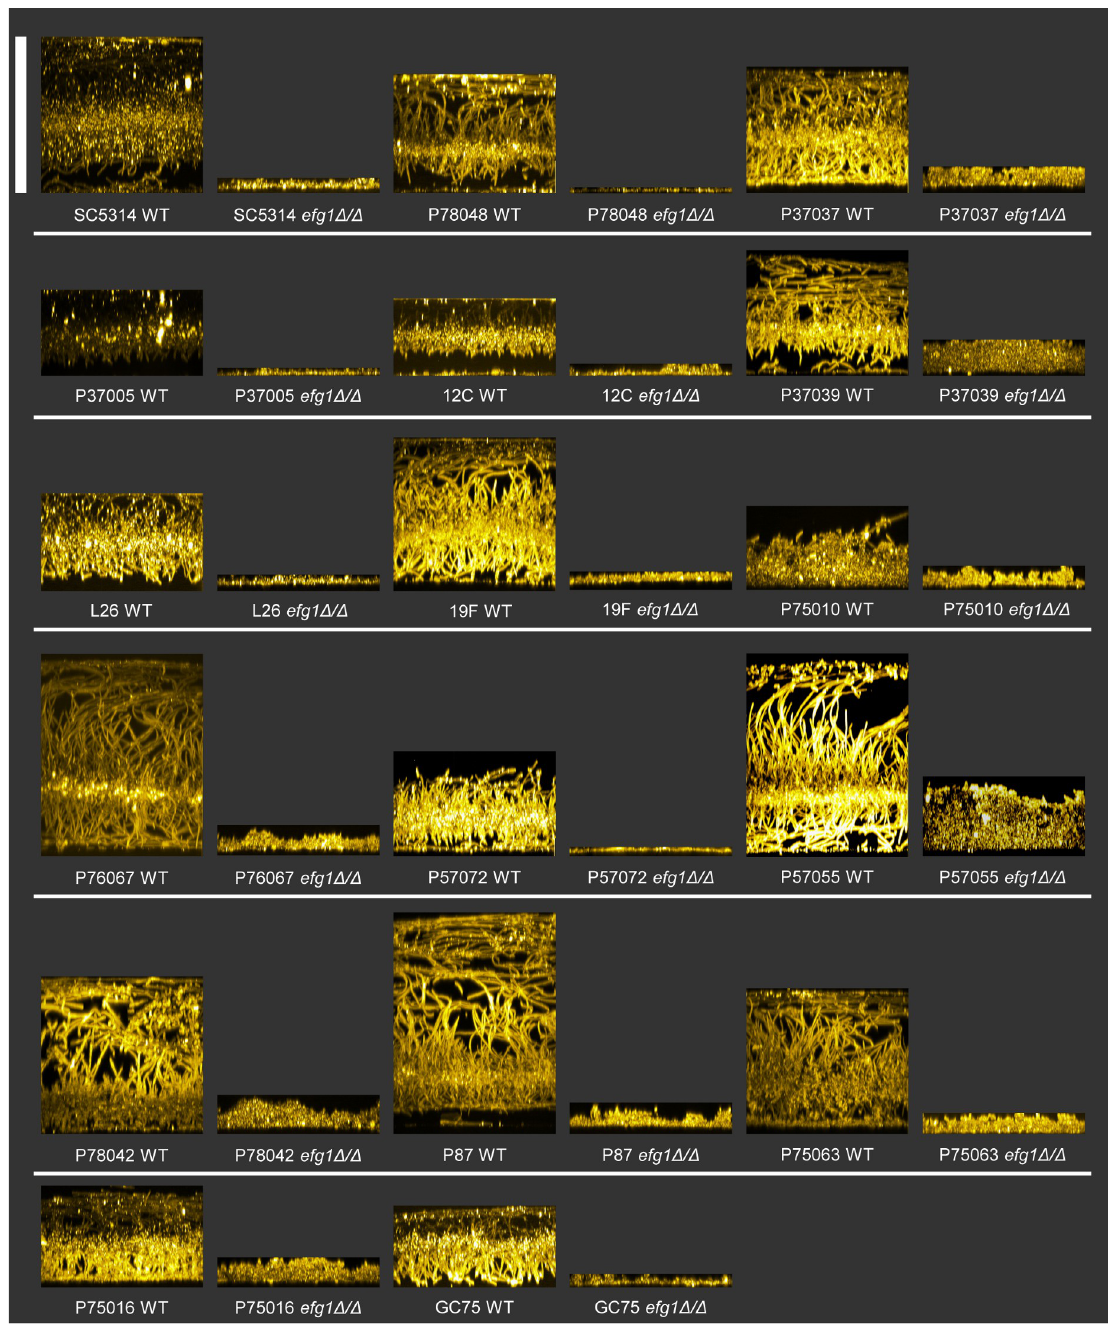
Fig 2. Biofilm formation ability. Clinical isolate WT and efg1 Δ / Δ strains were assayed for biofilm formation ability in RPMI+10% FBS at 37˚C for 24 hrs using the “Silicone substrate–confocal microscopy” method. Specimens were imaged using confocal microscopy and Alexafluor594-conjugated wheat germ agglutinin. Above are sideview images for both WT and efg1 Δ / Δ . Scale bar indicates 250 μ m. by Efg1 similarly in all 17 strains may reflect uniform features of Efg1 binding, effector activity, and interaction with other TFs across all strains. Another 42 genes are indirect Efg1 targets, which are genes whose 5’ regions are not detectably bound by Efg1 [11–13].